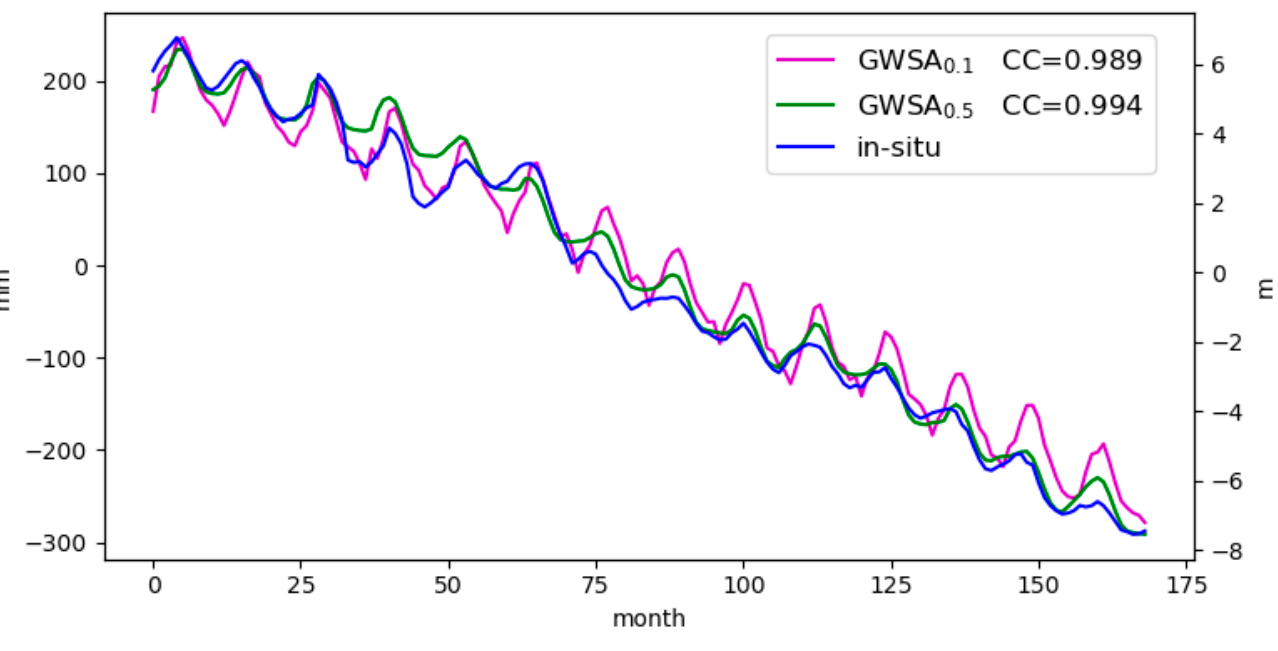
Figure 5. Comparison of downscaled GWSA 0.1 and original GWSA 0.5 with in situ groundwater level anomaly (GWLA). The pink, green and blue lines are associated with GWSA 0.1 and GWSA 0.5 (mm), and observations (m).